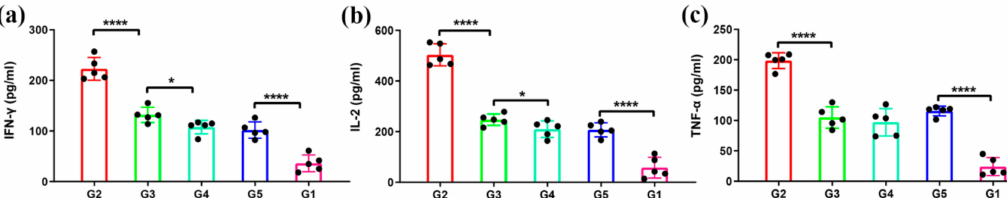
Figure 5. Immunization induced a significant cytokine response in mice. In order to evaluate antigen-specific T-cell responses, splenocytes were harvested from five mice in each group and were stimulated by MERS-CoV peptide S291 for 24 h. The level of secreted IFN- γ ( a ), IL-2 ( b ), and TNF- α ( c ) in the supernatants was detected by mouse ELISA kits. The data are shown as the mean ± SD and were analyzed by Student’s t -test (* p < 0.05, **** p < 0.0001, n =